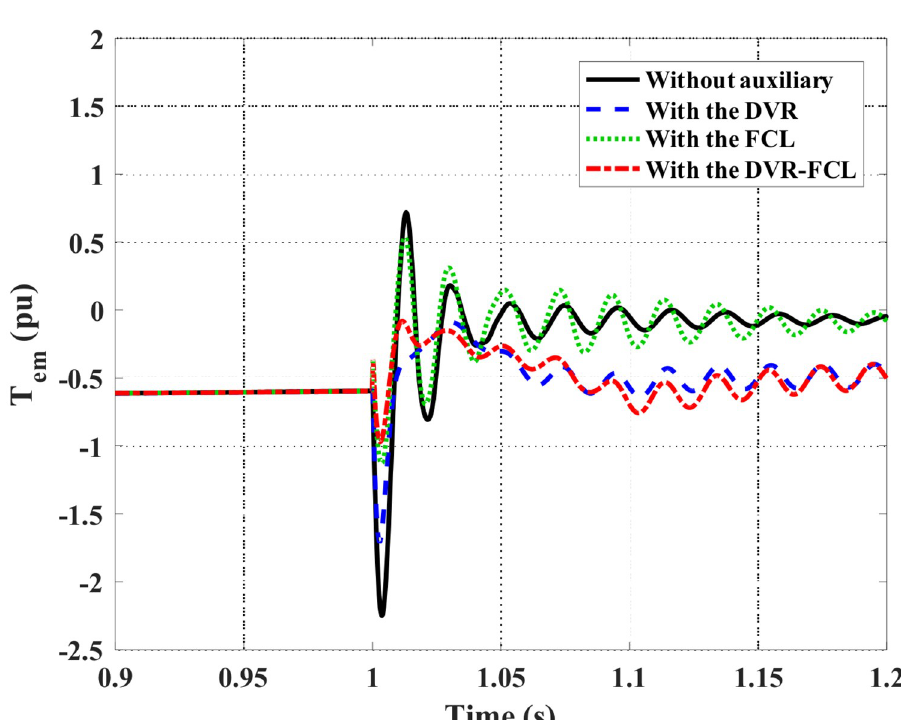
Fig 11. Electromagnetic torque of the DFIG subject to the symmetrical fault.